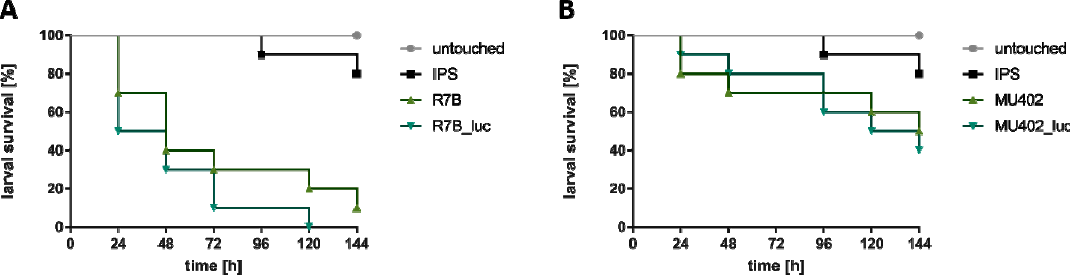
Figure 5. Survival of larvae infected with M. circinelloides strains. Larvae were infected with 10 6 spores of the respective strains and incubated at 30 ◦ C. ( A ) represents Kaplan-Meier curves of larvae infected with R7B or R7B_luc strain. ( B ) represents Kaplan-Meier curves of larvae infected with MU402 or MU402_luc strain. Survival was monitored every 24 h up to 144 h. Untouched larvae and larvae injected with IPS buffer served as controls. Results are expressed as the mean of three independent experiments (60 larvae in total).